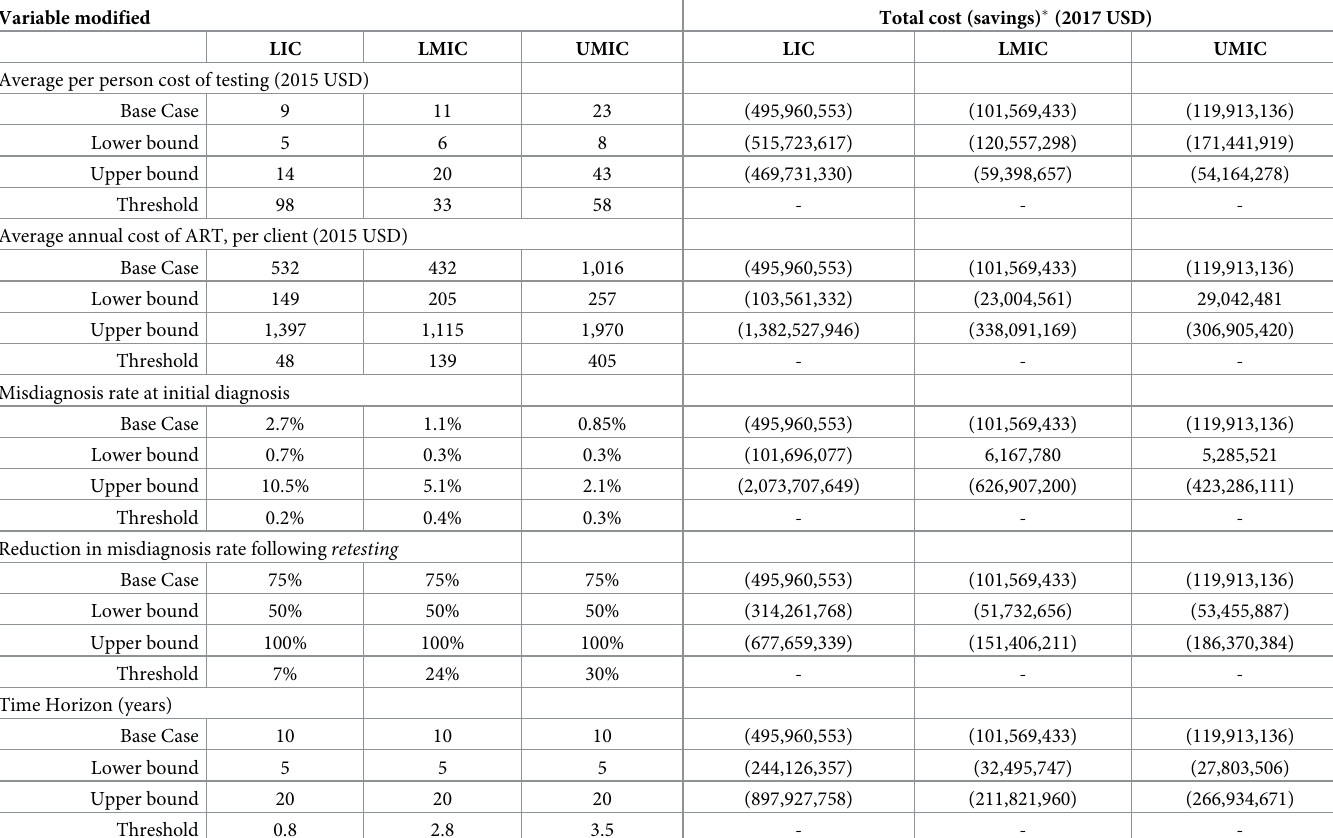
Table 5. Sensitivity and threshold analyses of retesting by low-income countries (LIC), lower-middle income countries (LMIC), and upper-middle income countries (UMIC) in